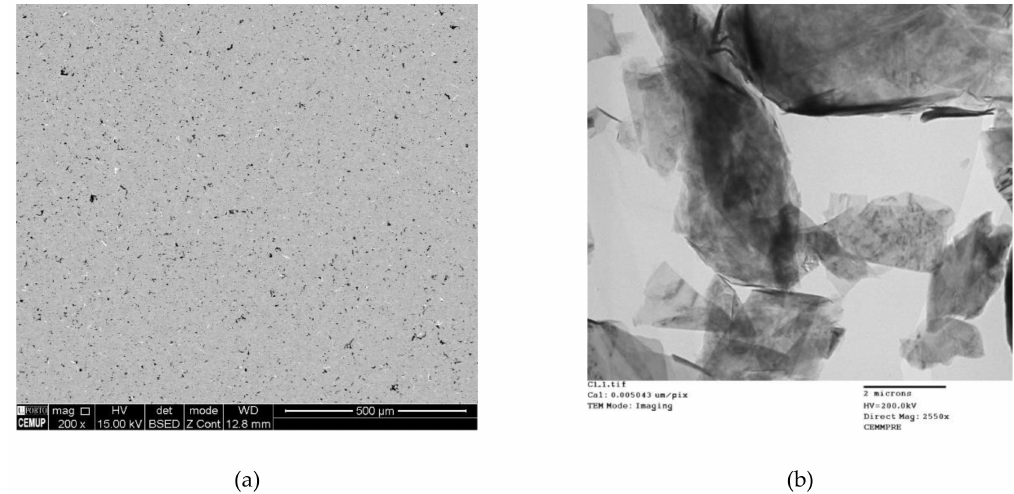
Figure 6. ( a ) SEM/BSE image from the as polished surface of the sintered Al-1 vol. % Graphene specimen; ( b ) TEM image showing the presence of graphene multi sheets after 15 min’ ultrasonication.